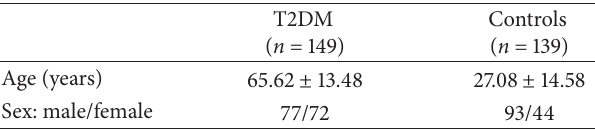
Table 1: Characteristics of